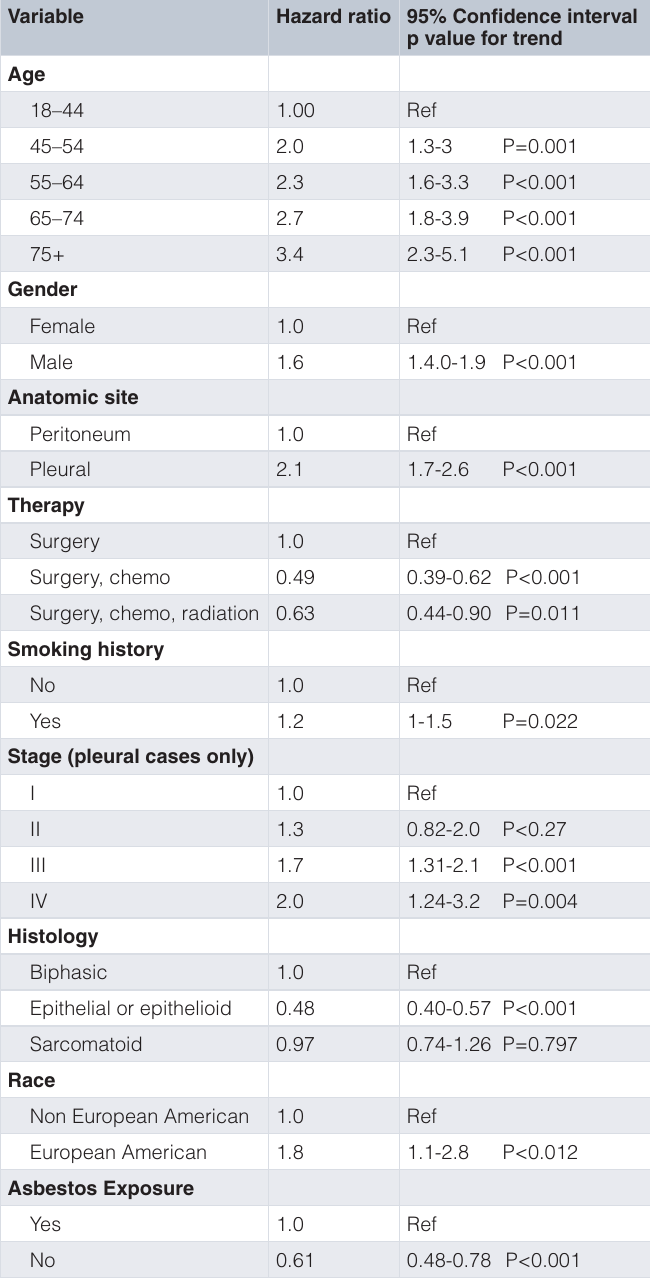
Table 2. Unadjusted Cox Hazard Regression Analysis, predictors of mesothelioma survival (n=888). Ref – Reference